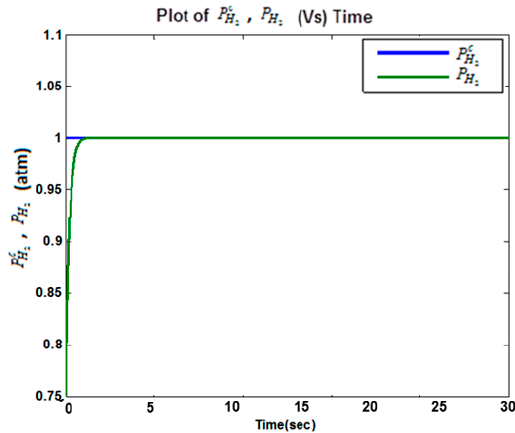
Figure 10. Plot of HFC current controller v 4 ( kmol / s ) .